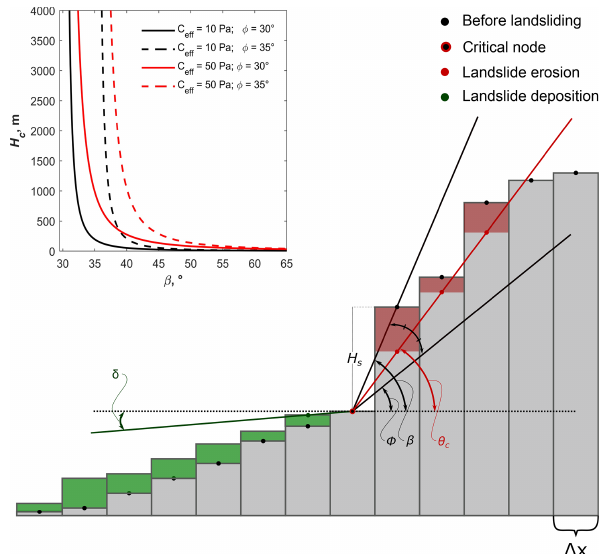
Figure 3. Sketch of landslide algorithm in two dimensions. Land- slide erosion (red shaded area) is calculated using the Culmann ap- proach (Culmann, 1875). β is the topographic slope; φ represents the angle of internal friction, and θ is the inclination of the rup- ture plane. Deposition of landslide-derived sediment (green shaded area) is calculated using a nonlocal diffusion equation (Eq. 11; see Carretier et al., 2016). δ is the minimal deposit surface angle at which landslide-derived sediment is distributed on the hillslope. This sketch illustrates a case where none of the landslide-derived = 0 ) and the amount of sediment is in permanent suspension (F f hill eroded sediment (red shaded area) equals the amount of deposited sediment (green shaded area). If the deposited volume creates a downslope gradient which is lower than δ , the slope of the deposited volume is adjusted so that the deposit surface angle equals δ . Proba- bility for sliding is calculated as the ratio of the local hillslope height H s to the maximum hillslope height H c (Eq. 7; see Densmore et al., 1998). The inset plot illustrates that H c depends on the rock strength (cohesion C and internal friction angle φ ) and the topographic slope β . The plotted lines are calculated using Eq. 8, where ρ is 2700 kgm − 3 and g = 9.81 m s − 2